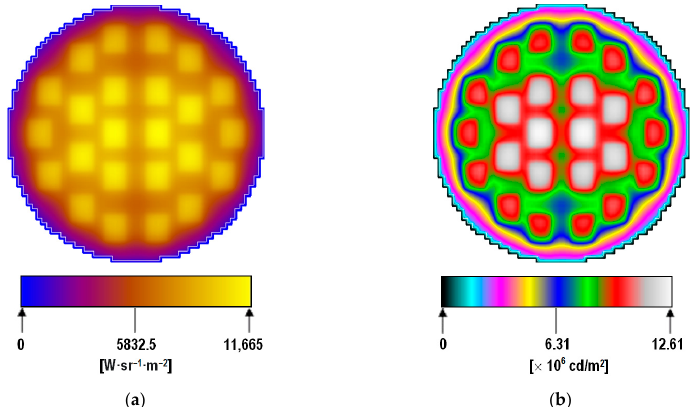
Figure 27. Simulated radiance and luminance distributions on the top of the phosphor (model setup: 400 mA driving current, 25 °C ambient temperature, light propagation described by model g) presented in Section 5.1, with equal blue and yellow absorption, 90% importance level): ( a ), radiance map; ( b ) luminance map.